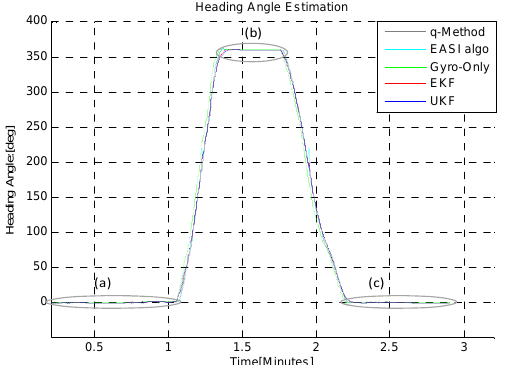
Figure 17. Continuous rotation (0~360°) in CW and CCW direction in the TiP test (B ‐ iii). The EASI algorithm output gives a noisy but stable heading angle. EKF and UKF show similar performance in this short time continuous rotation experiment. The q ‐ Method does not perform well, as compared to the EASI , due to sensor’s continuous motion.